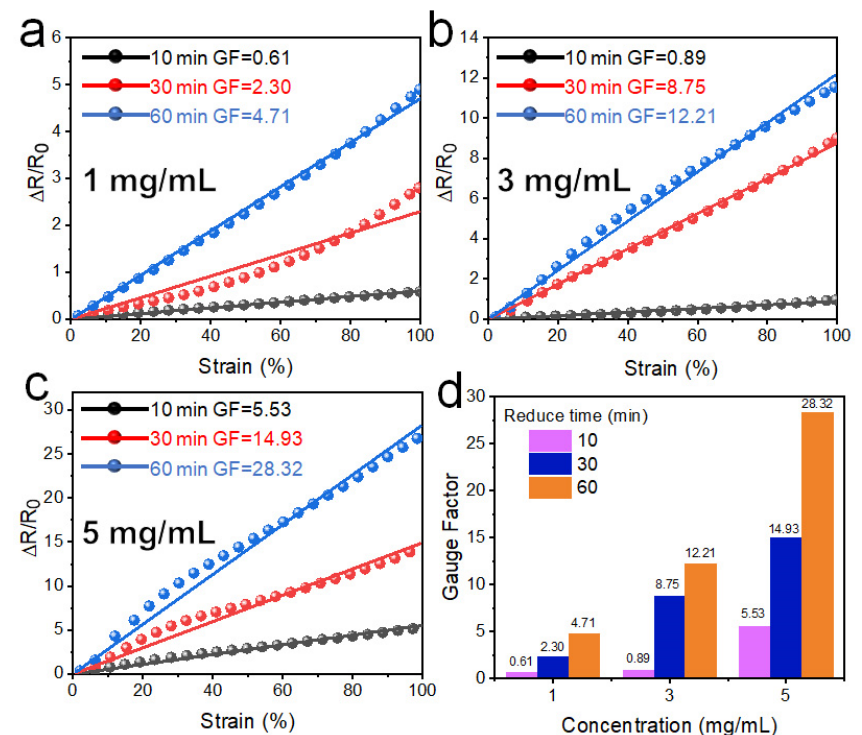
Figure 11. Strain-sensing curves in different reduction time at a concentrate of ( a ) 1 mg mL − 1 , ( b ) 3 mg mL − 1 , ( c ) 5 mg mL − 1 . ( d ) Statistical bar chart of GF in various concentrates and reduction time.